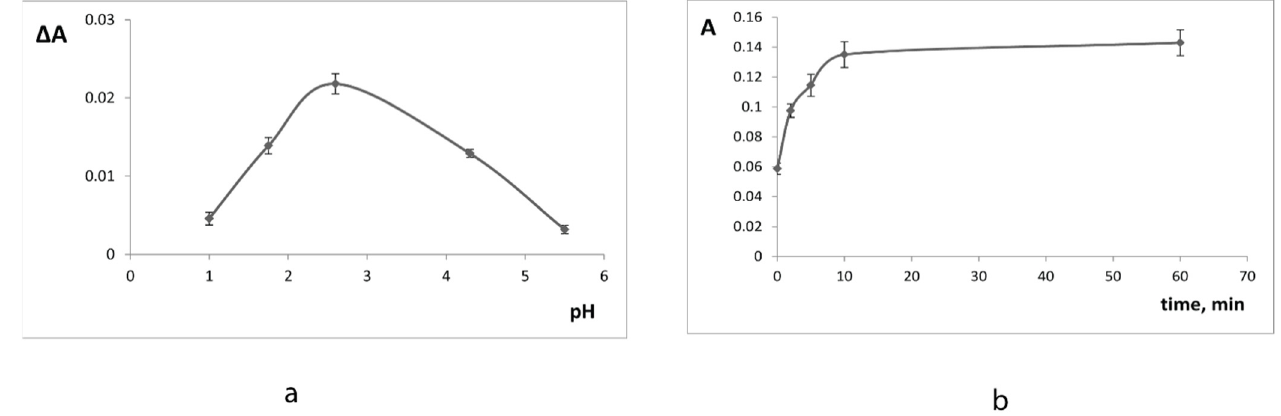
Figure 3. The influence of pH ( a ) and time of contact ( b ) on the interaction of SiFe xerogel with 0.075 M 1,10-phenanthroline and catechol. Δ A = A catechol − A blank .